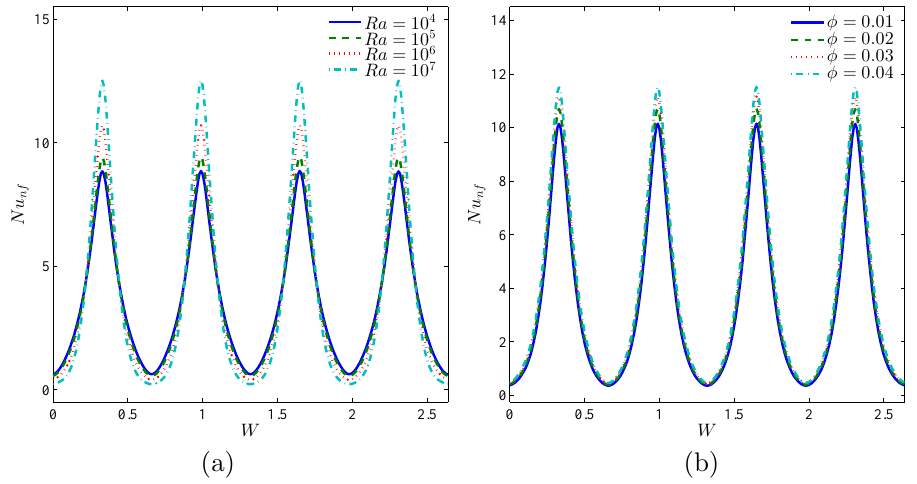
Figure 15. Variation of local Nusselt number interfaces with the wavy W for different ( a ) Ra and ( b ) φ at N = 4 and A =